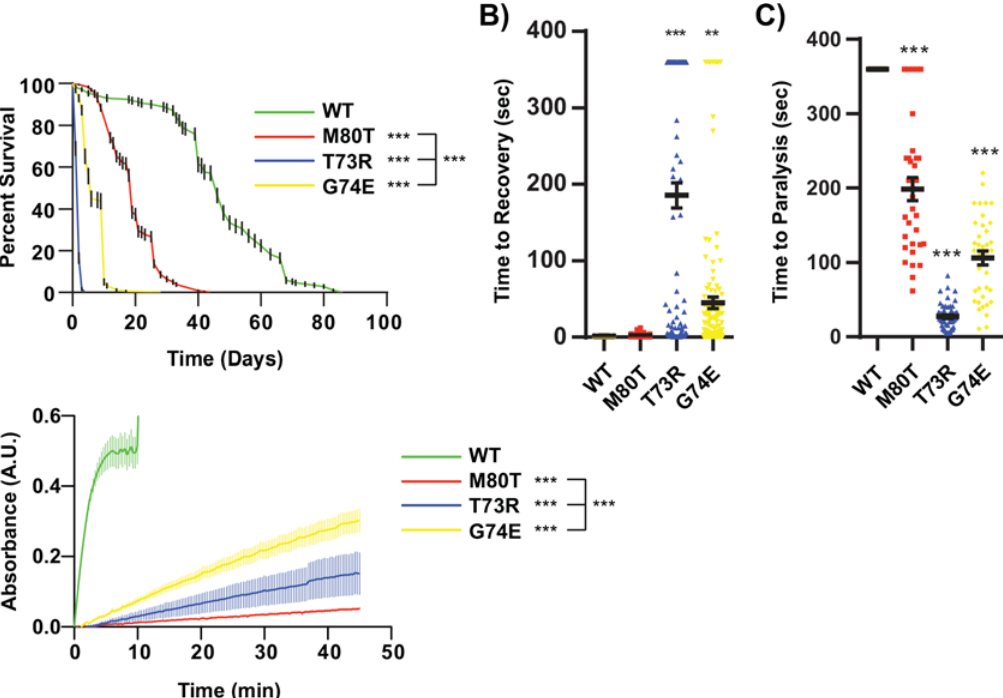
Fig 2. Mutations affecting the TPI dimer interface recapitulate dTPI M80T phenotypes. (A) dTPI T73R and dTPI G74E homozygotes display severely reduced lifespans, n > 150. (B) Dimer interface mutations exhibit severe mechanical stress at Day 1 and (C) thermal stress sensitivity at Day 2, n > 30. Thermal stress paralysis times at 360 sec. represent wild type behavior, the assay was stopped at 6 min. (D) Both dTPI T73R and dTPI G74E homozygotes display reduced lysate isomerase activity, n (cid:1) 3. Comparisons were made with a One-way ANOVA using Tukey ’ s post hoc test, and lifespans by a Log-rank (Mantel-Cox) survival test, ** indicated p < 0.01, *** p < 0.001.